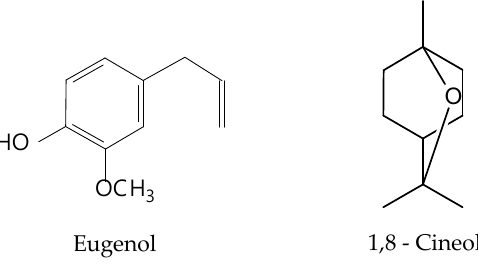
Figure 1. Chemical structures of the major constituents from the EO of Ocimum gratissimum L. (EOOG) dry leaves.